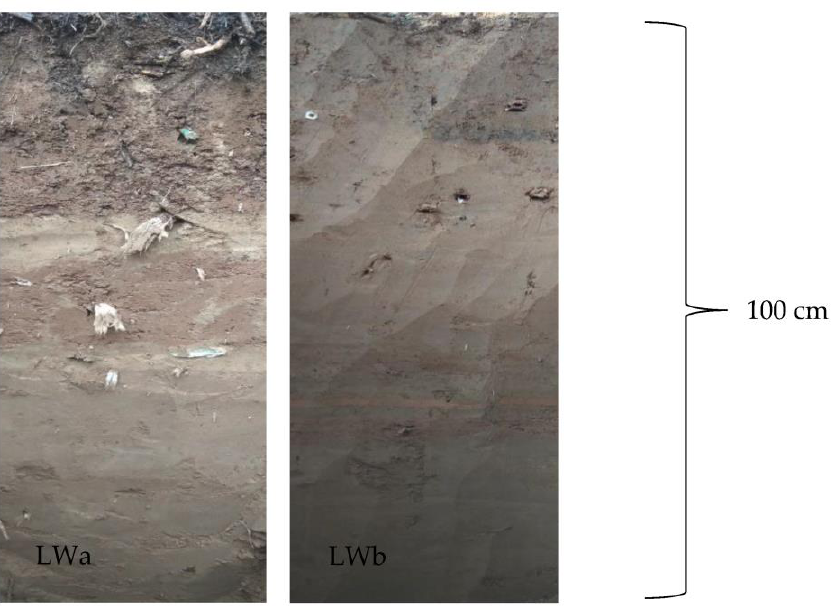
Figure 7. Photographs of sampling site soil profiles.